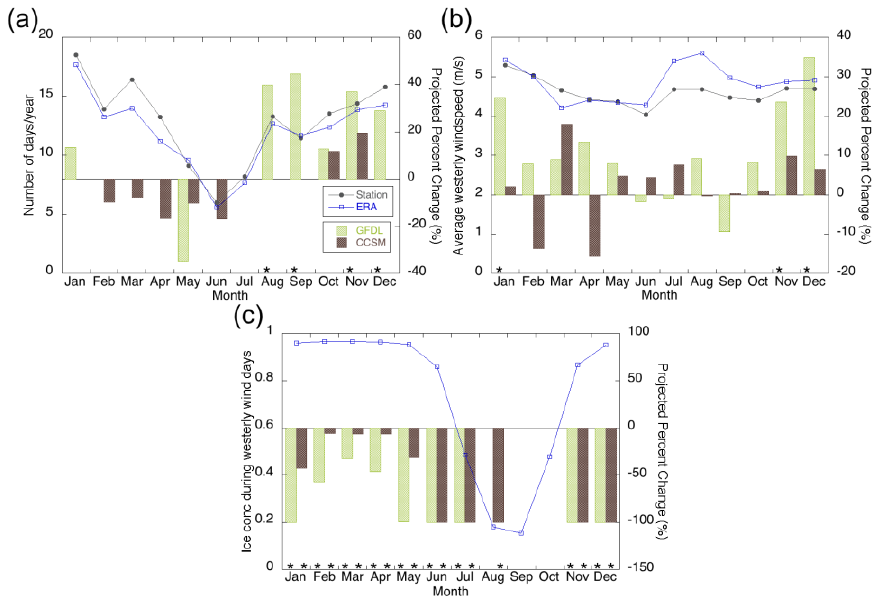
Figure 4. Monthly historical climatology (1991–2010; lines) and projected percent change over 2015– 2100 (bars) for the ( a ) number of days with westerly winds, ( b ) average wind speed on days with westerly winds, and ( c ) daily average sea ice concentration during westerly wind days. Trends significant at the 95% or greater level are marked with an asterisk along the x -axis.